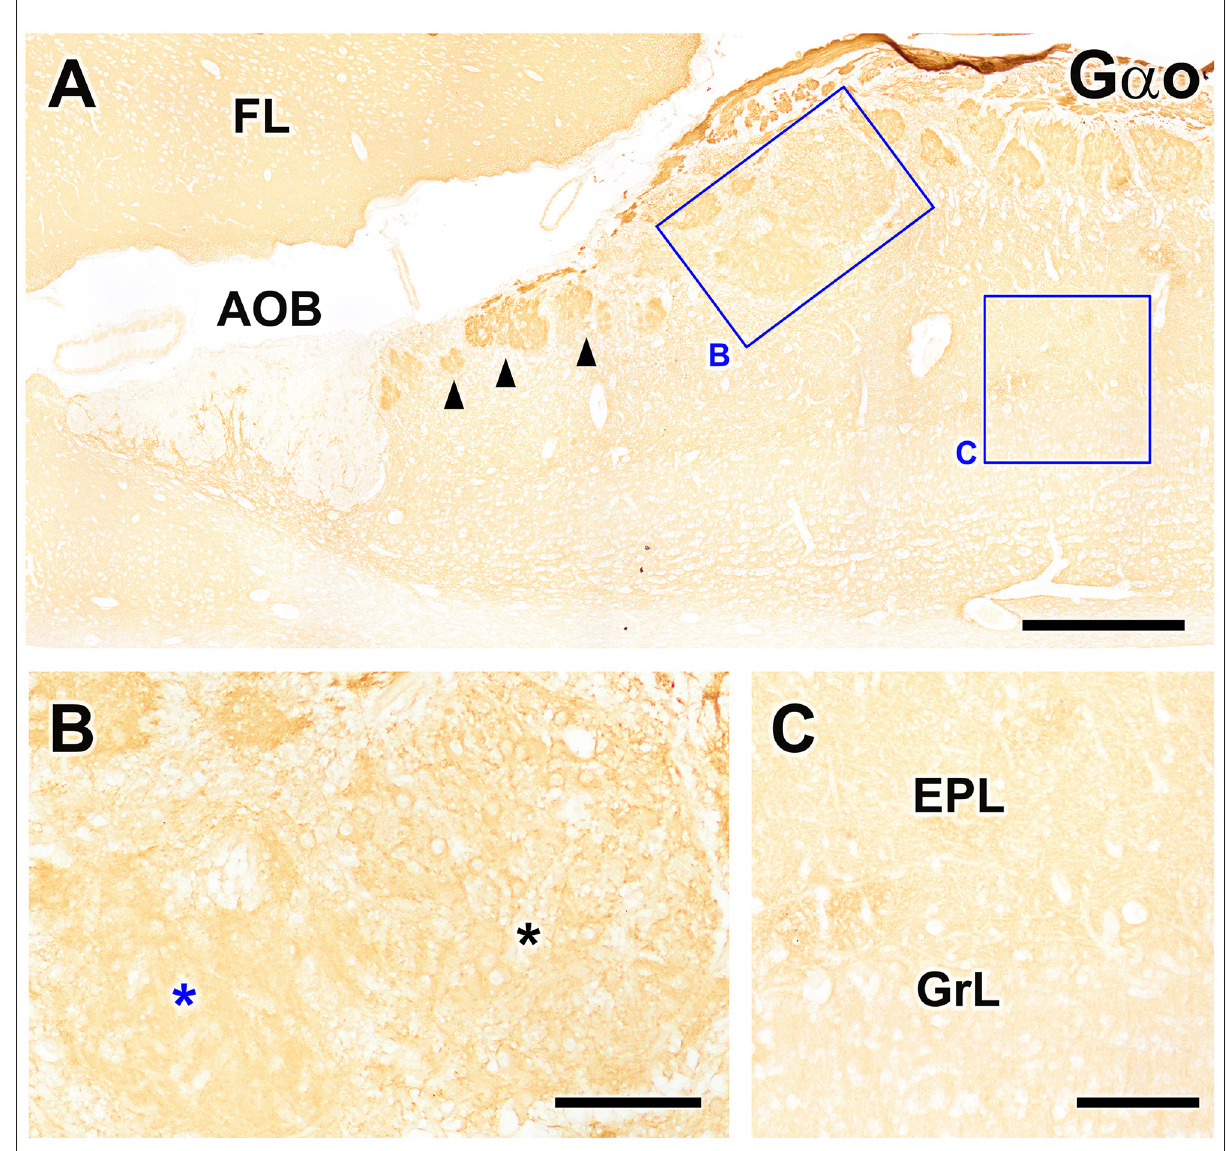
FIGURE7 Immunohistochemical labeling of the fox olfactory limbus (OL) using anti-G α o. (A) Immunolabeling for the G-protein subunit G α o revealed uniform expression of G α o throughout the frontal lobe of the telencephalon (FL) and the olfactory bulb, but no immunostaining in the nerve or glomerular layers of the accessory olfactory bulb (AOB). Atypical glomeruli proximal to AOB (arrowheads) are more intensely immunolabeled with anti-G α o than typical glomeruli in the main olfactory bulb (MOB). The macroglomerular complex (MGC, box B ) shows a labeling intensity similar to the typical MOB glomeruli. (B) Higher magnification of box (B) , showing that the MGC possesses two clearly differentiated areas: one containing numerous neuronal somata (black asterisk) and one devoid of somata (blue asterisk). Somata in the MGC are G α o-immunopositive, unlike the mitral cell somata in the MOB, which are immunonegative (box C , C ). EPL, external plexiform layer; GrL, granular layer. Scale bars: (A) : 500 µ m. (B,C) : 125 µ